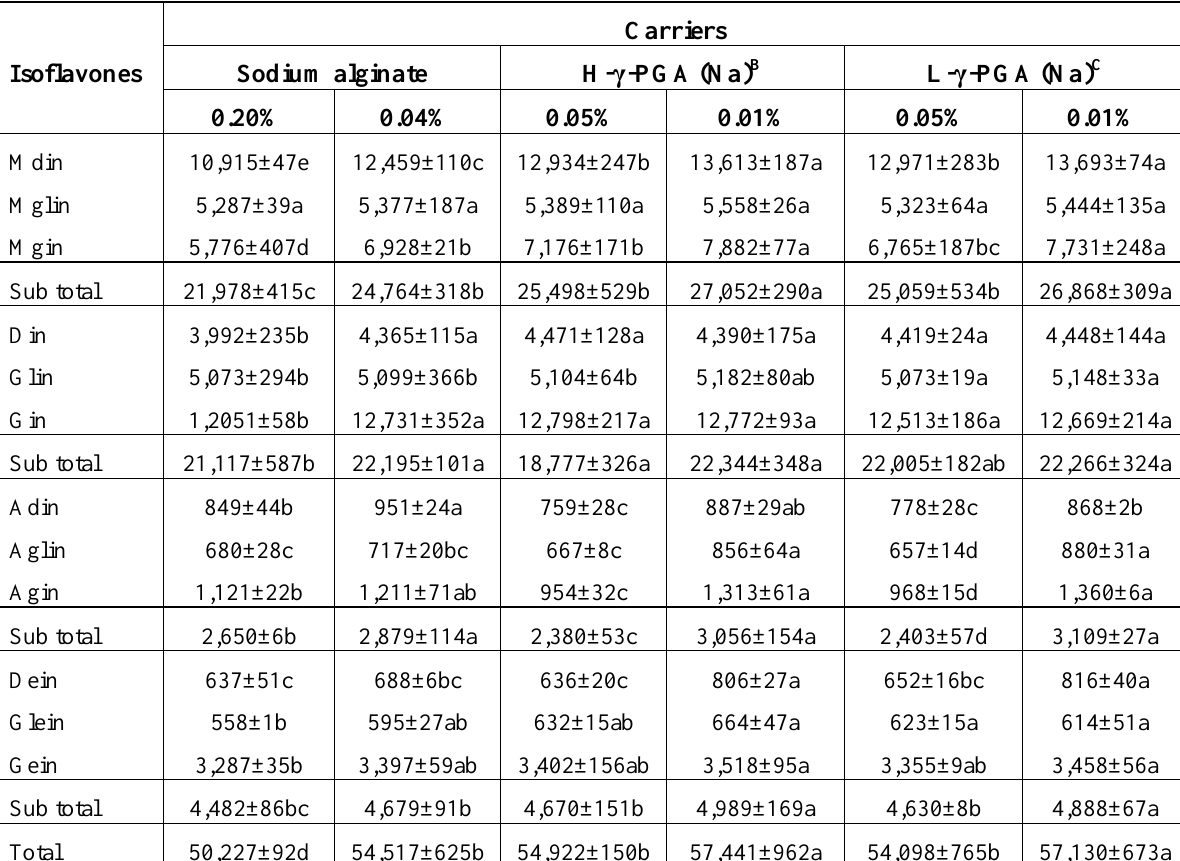
Table 3. Isoflavone contents ( μ g/g) A in the vacuum-dried powder with H- γ -PGA (Na) B and L- γ -PGA (Na) C or sodium alginate as carrier D